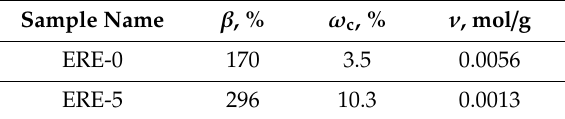
Table 2. The results of swelling and crosslinking degree calculations for the samples of composite elastomers based on polydimethylsiloxane and titanium dioxide, cured in, and in the absence of, an electric